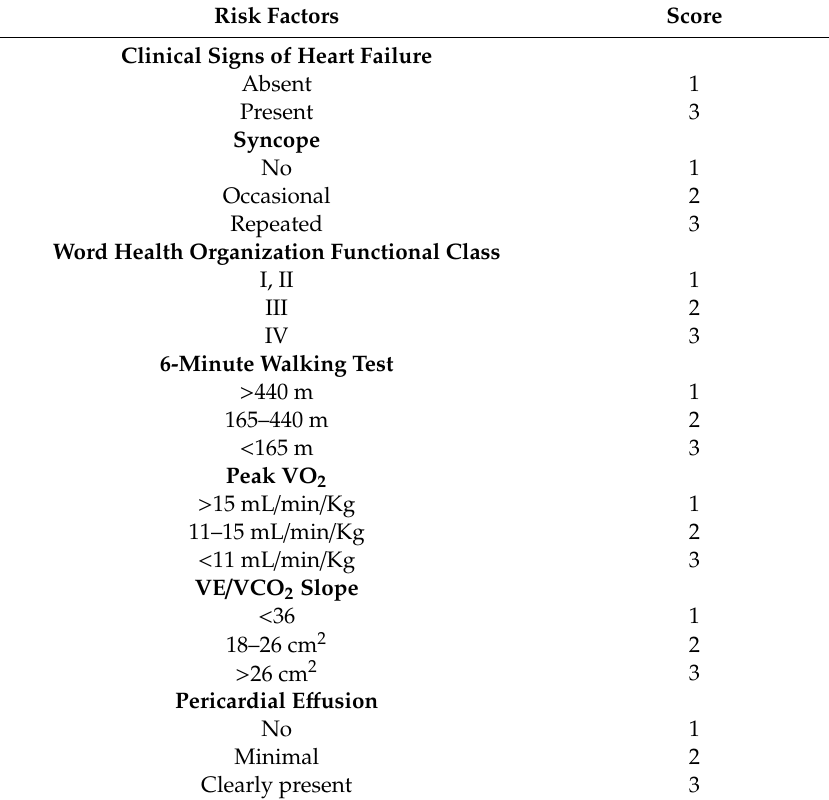
Table 1. Score of cardiovascular